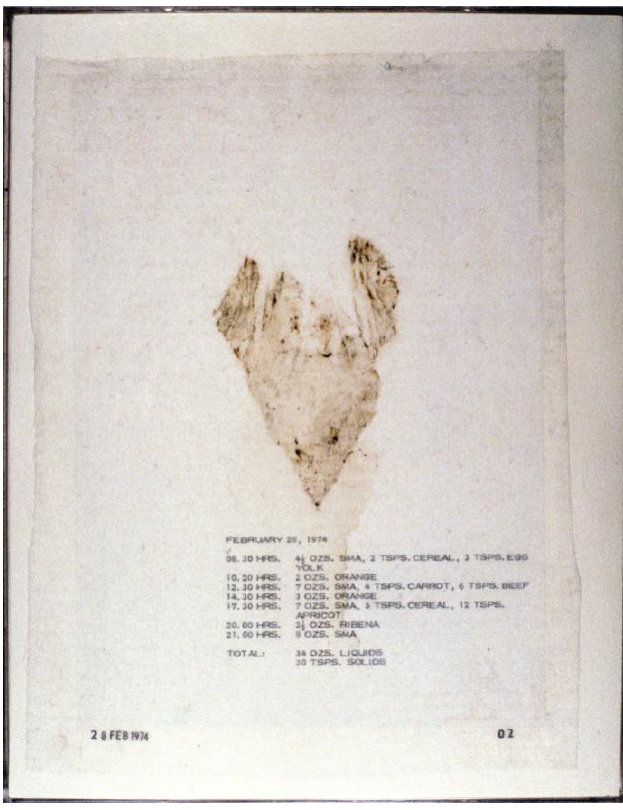
Figure 3: Mary Kelly Post-Partum Document, Documentation I Analysed Fecal Stains and Feeding Charts, 1974, (detail, 1 of 28)